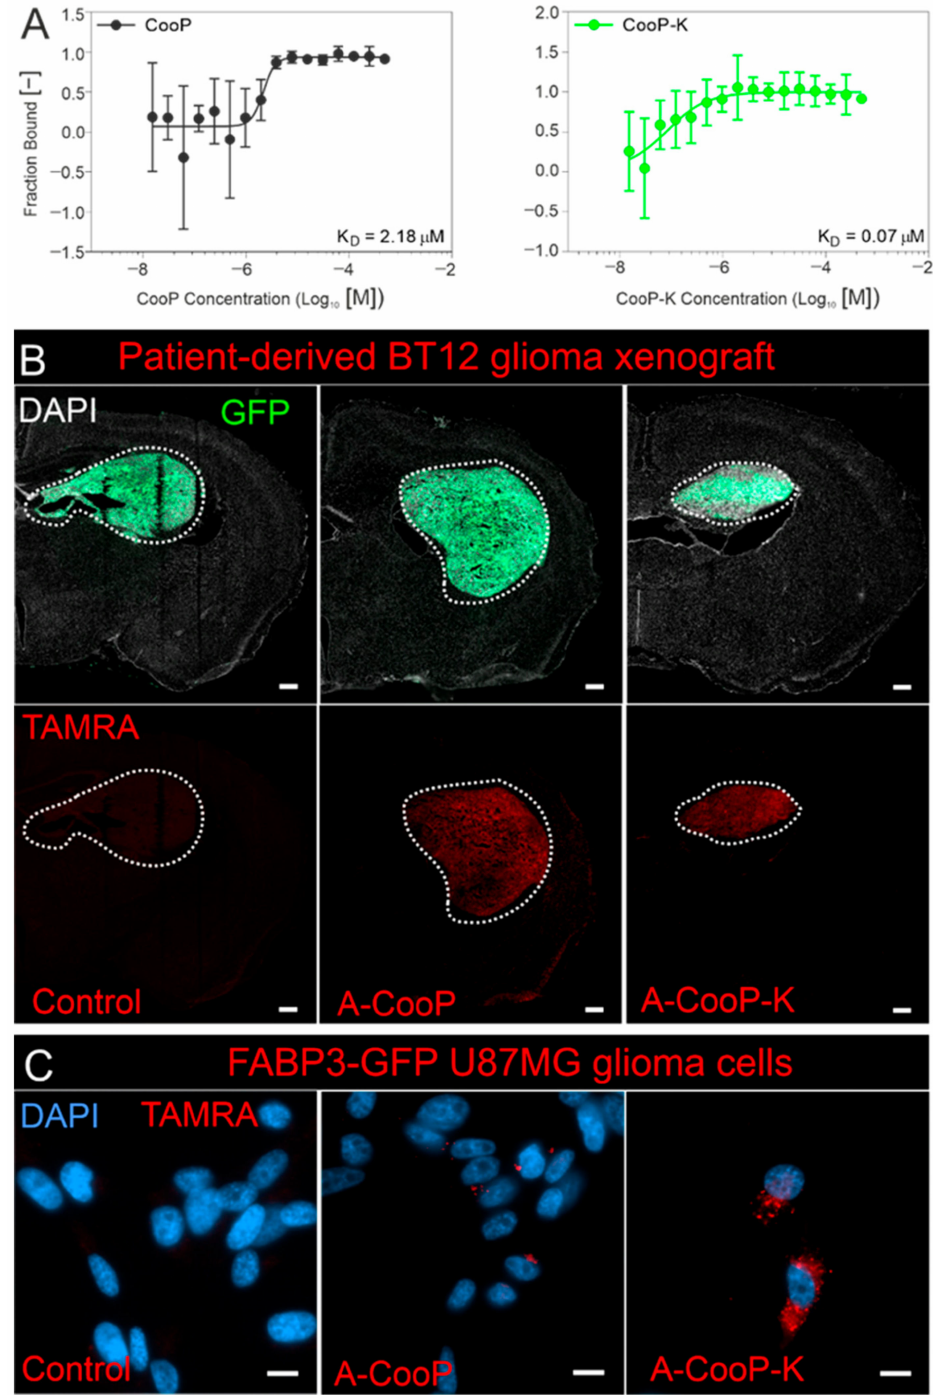
Figure 3. Homing and internalization of the A-CooP and A-CooP-K peptides to intracranial glioblas- tomas. ( A ) Affinity measurements (calculated K D ) of the A-CooP and A-CooP-K peptides binding to recombinant FABP3/MDGI. ( B ) A-CooP and A-CooP-K home efficiently to the patient-derived BT12 glioblastoma xenografts while the control peptide showed no homing, scale bar = 1 mm. ( C ) Widefield fluorescence images of mammary-derived growth inhibitor/fatty acid binding pro- tein 3 (MDGI/FABP3) overexpressing U87MG cells show efficient internalization of the A-CooP-K peptide compared to the A-CooP (red) with minimal internalization and control peptide with no internalization, scale bar = 10 µ m. Ayo et al. unpublished